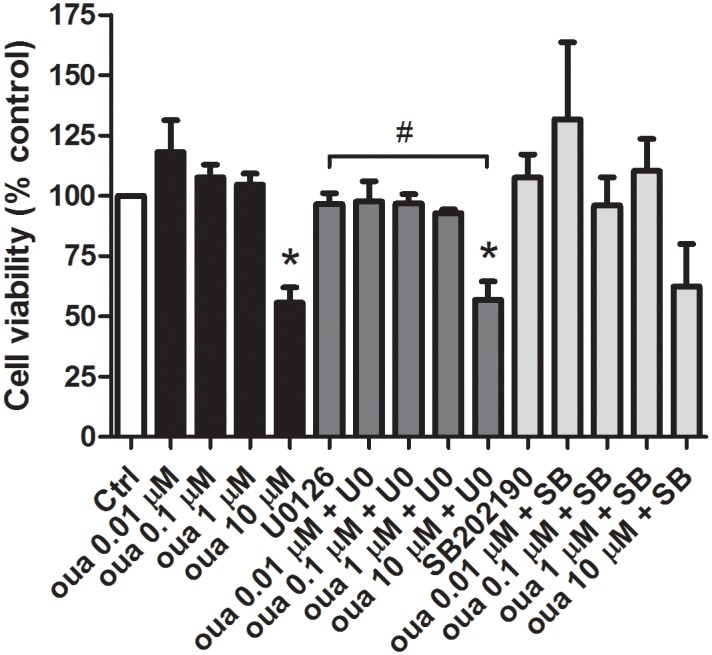
Effects of ouabain in cell viability.Chick myogenic cells were grown for 24 h and treated with different concentrations of ouabain for 24 h. A MTT-based method was used to analyze cell viability in untreated and ouabain-treated cells. Data represent mean absorbance minus background from triplicate wells. *p<0.05 compared to untreated cells (Ctrl) and #p<0.05 for comparison to the respective control; one-way ANOVA on Ranks with Newman-Keuls Post Hoc test; n = 3.